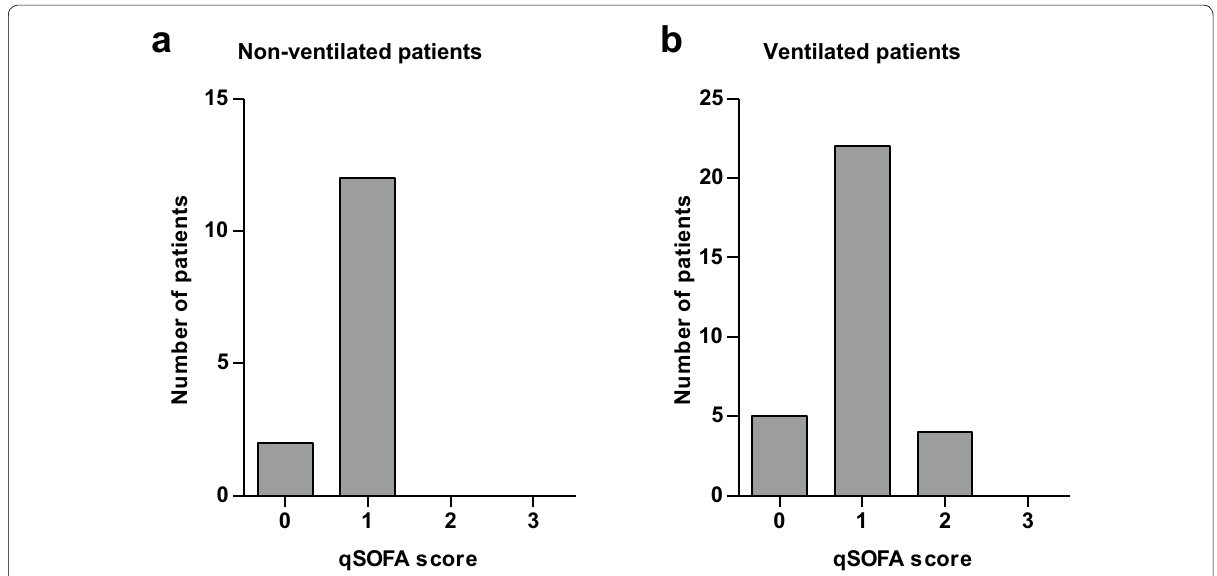
Fig. 1 Distribution of patients by qSOFA score on ICU admission among confirmed Covid‑19 patients. a Non‑ventilated patients. b Ventilated